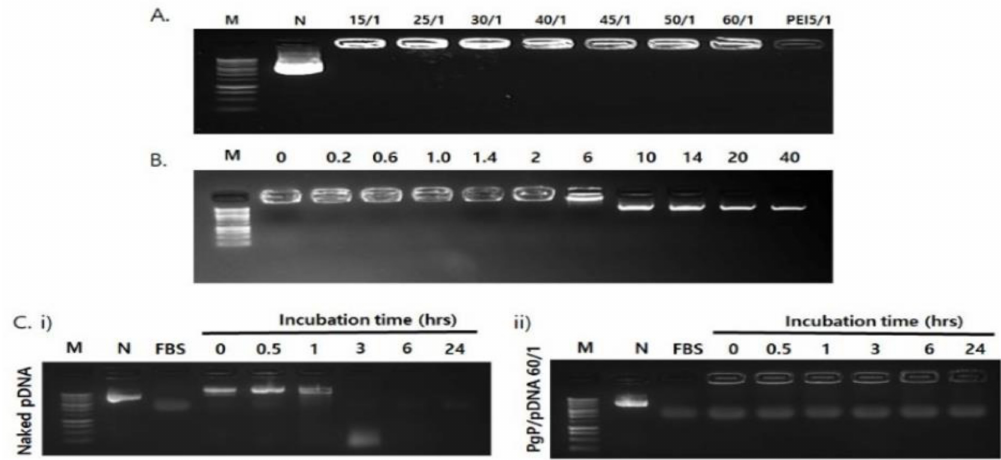
Figure 2. Analysis of polyplex stability. ( A ) Gel retardation assay of PgP / pDNA polyplexes at